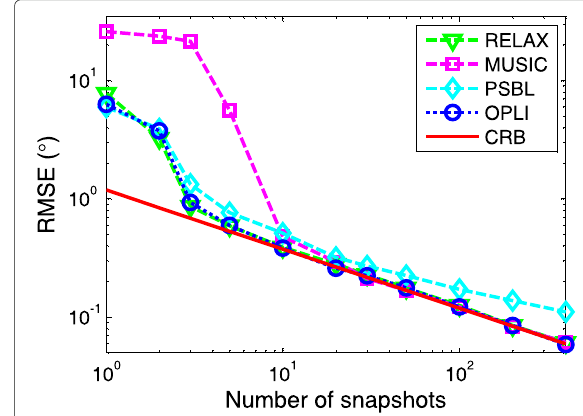
Fig. 5 RMSE versus the number of